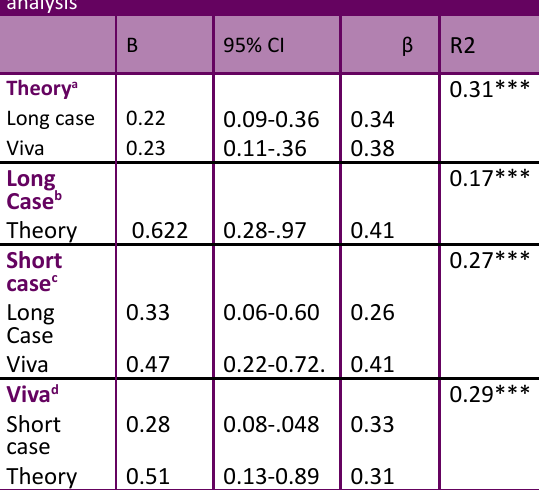
Table 4– Prediction of MD psychiatry examination component scores using stepwise multiple regression